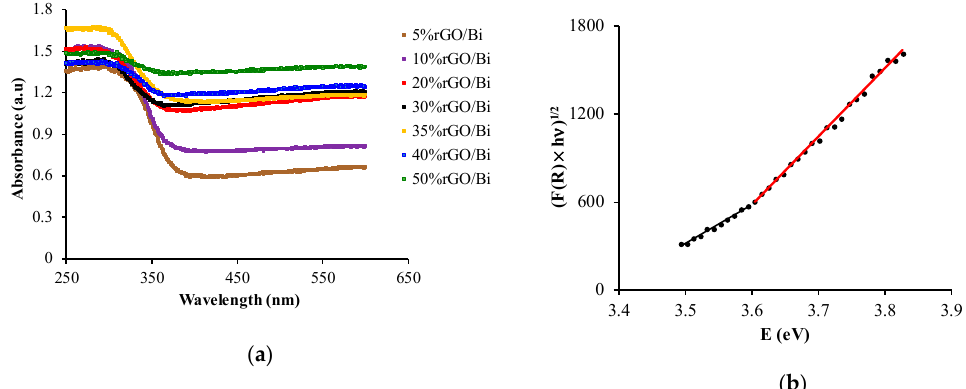
Figure 7. ( a ) UV–Vis spectra and ( b ) relationship between transformed Kubelka–Munk function and light energy for 5%rGO/Bi.